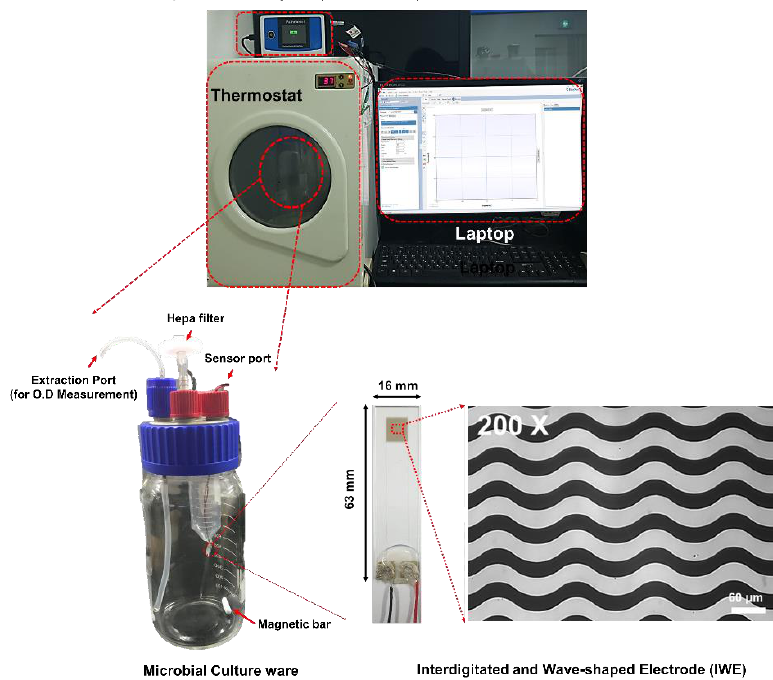
Figure 1. Schematic representation of the capacitance monitoring system for bacteria using the developed interdigitated and wave-shaped electrode (IWE) with microbial culture platform.